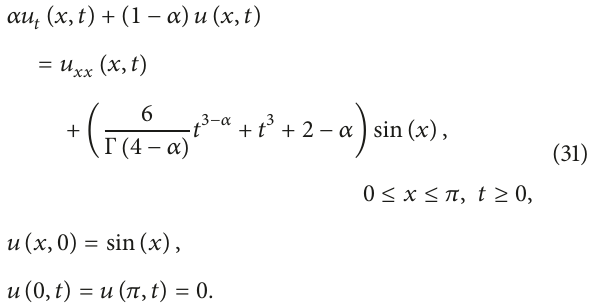
Table 1: Maximum norm relative errors of the proposed approxi- mate-analytical solution, NSFD method, and SFD technique for Example